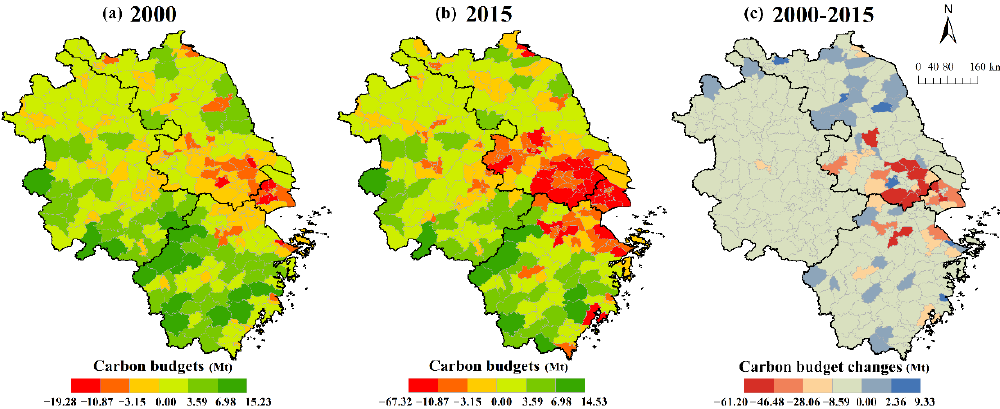
Figure 4. Spatial distribution and changes in the carbon budget from 2000 to 2015 in the YRD region. Land 2022, 11, x FOR PEER REVIEW